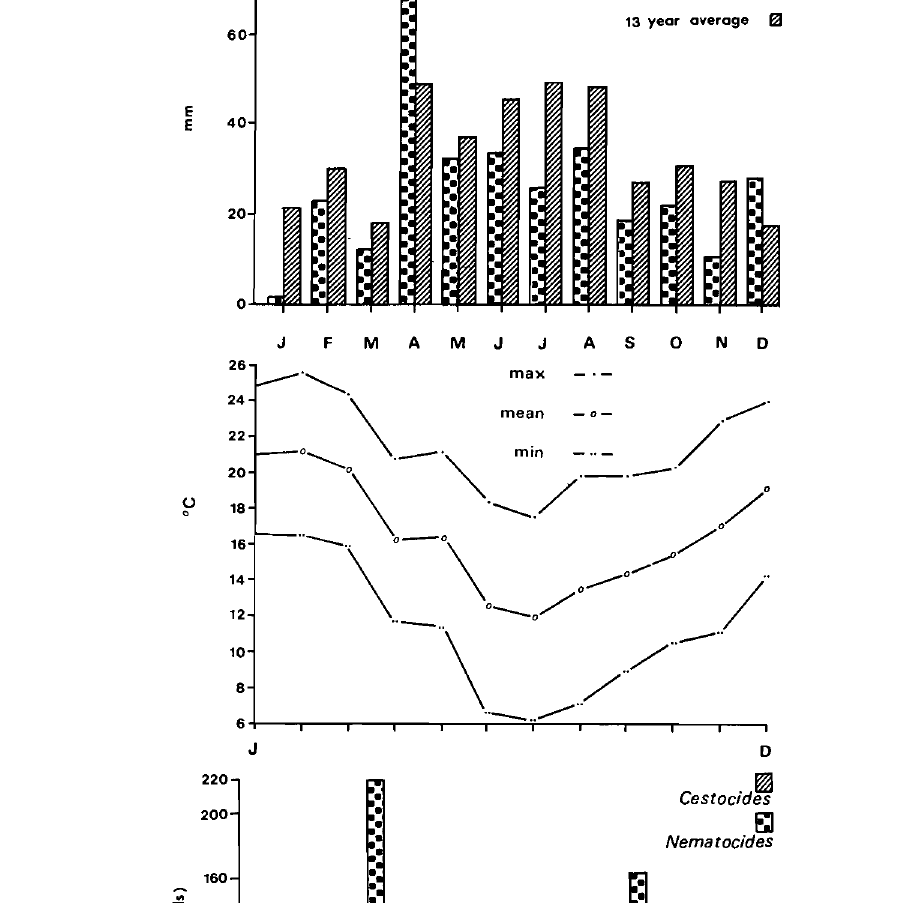
Monthly sales of nematocides and cestocides for sheep and goats, together with temperature and rainfall recorded in the Bredasdorp area during 1988 350 Market segment therapeutic dose (327 764 doses)